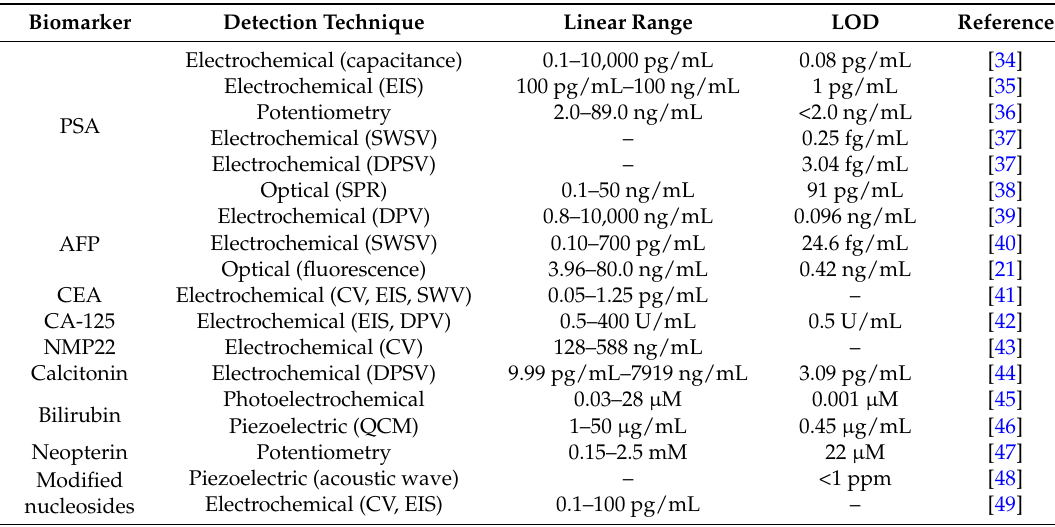
Table 3. Analytical parameters of MIP-based sensors for cancer biomarker